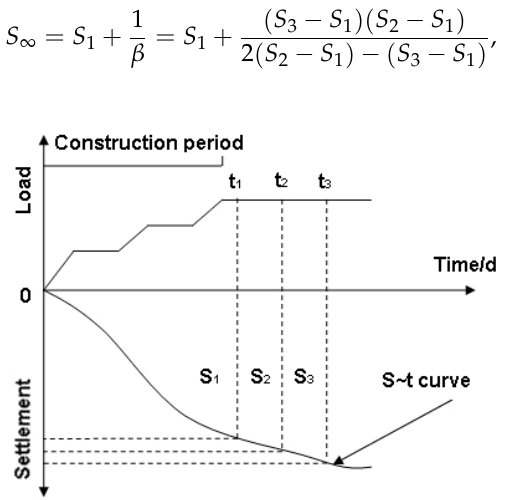
Figure 6. The schematic diagram of the three-point method.